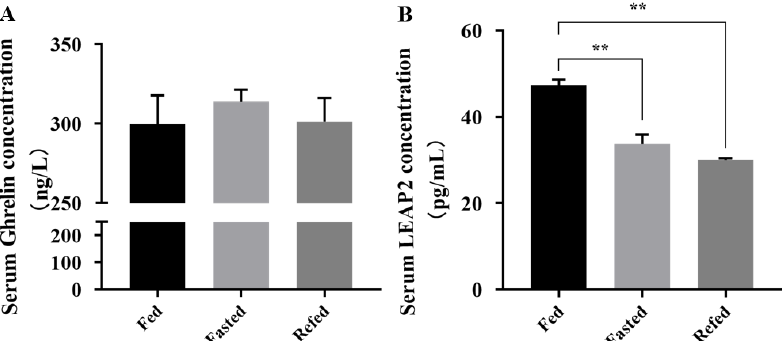
Figure 3. Serum concentrations of ghrelin ( A ) and LEAP2 ( B ) in chicks under different energy states (fed, fasted, and refed). Error bars indicate the SE (n = 6). ** indicates significant differences ( p ≤ 0.01). Abbreviation: LEAP2, liver enriched antimicrobial peptide 2.